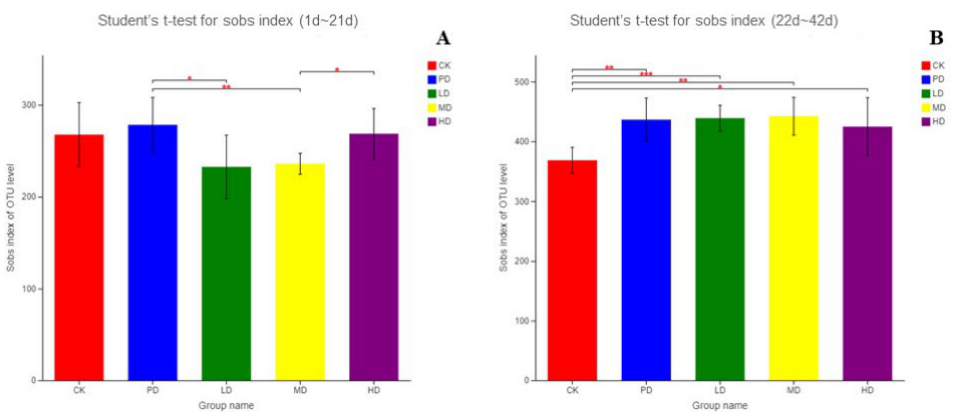
Figure 9. Difference analysis of Alpha diversity between groups ( A ): the early stage (1~21d), ( B ): the late stage (22~42d). Note: * indicate significant differences between groups according to the Tukey test. (*: p < 0.05; **: p < 0.01; ***: p < 0.001).